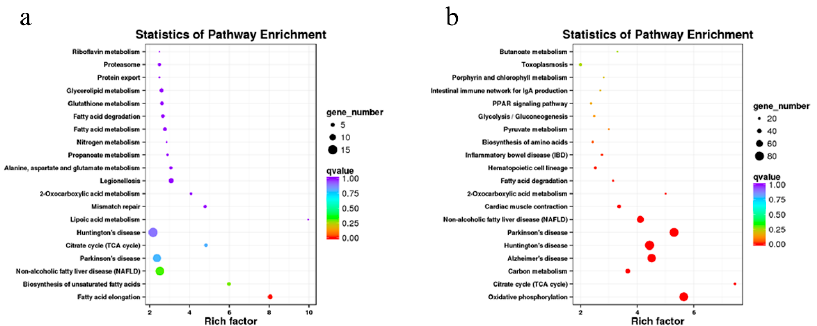
Figure 4. KEGG pathway map of di ff erently expressed lncRNAs in perirenal fat of goats. Top 20 significantly enriched KEGG pathways for cis - ( a ) and trans -regulated ( b ) target genes of lncRNAs. Each scatter point represents a pathway. The size of each point represents the degree of enrichment, and the color of each point represents the size of the q -value. The q -value represents multiple hypothesis testing using the Benjamin–Hochberg procedure